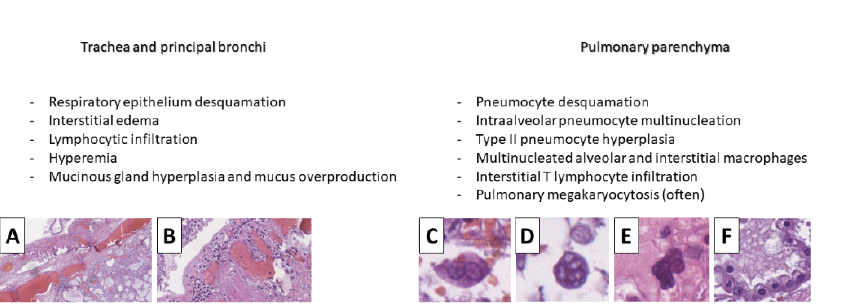
Figure 2. Histological features of SARS-CoV-2-induced damage in the trachea, principal bronchi, and the acute phase of pulmonary involvement: ( A ) respiratory epithelium desquamation, edema, lymphocytic infiltration, and mucinous gland hyperplasia in the trachea; ( B ) lymphocytic infiltrate in the tracheal submucosa around hyperemic blood vessels; ( C ) alveolar multinucleated cell of pneumocyte origin; ( D ) alveolar multinucleated cell of macrophage origin; ( E ) pulmonary megakaryocyte; ( F ) type II pneumocyte hyperplasia. Note: Histology sections adapted from ref. [60].